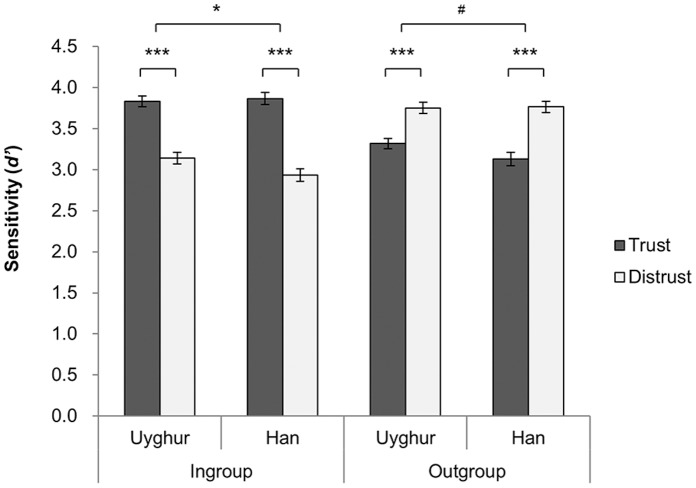
In-group trust and out-group distrust.
d’ values for Han and Uyghur participants toward In−/out-group+Trust/Distrust. Error bars denote standard error of mean (S.E.M.). * indicates p<.05, *** indicates p<.001, # indicates p<.10.